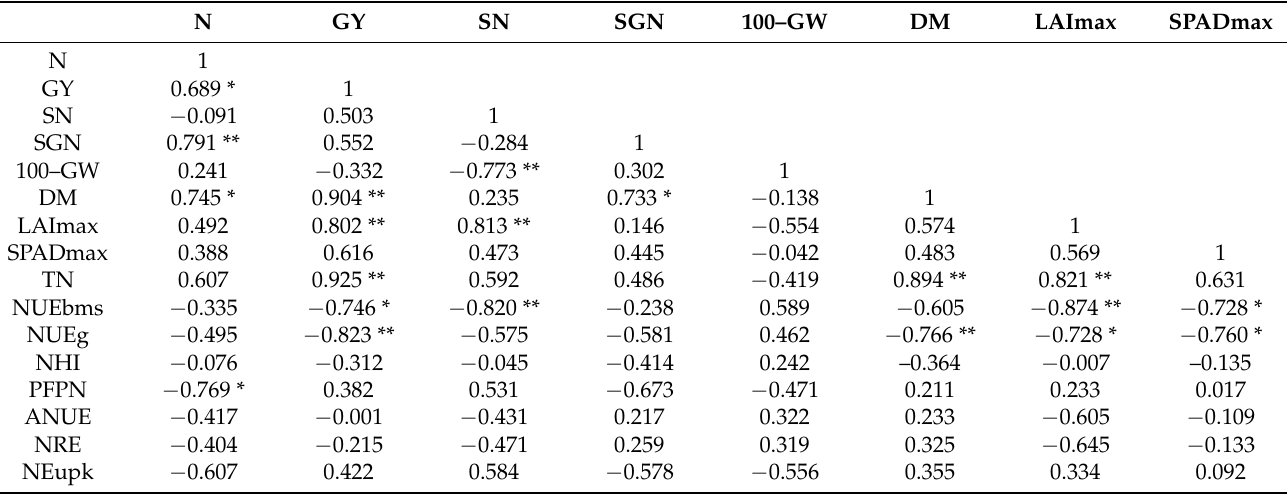
Table 4. The correlations between GY and its components, DM, LAImax and SPADmax and nitrogen accumulation and utilization of spring wheat.